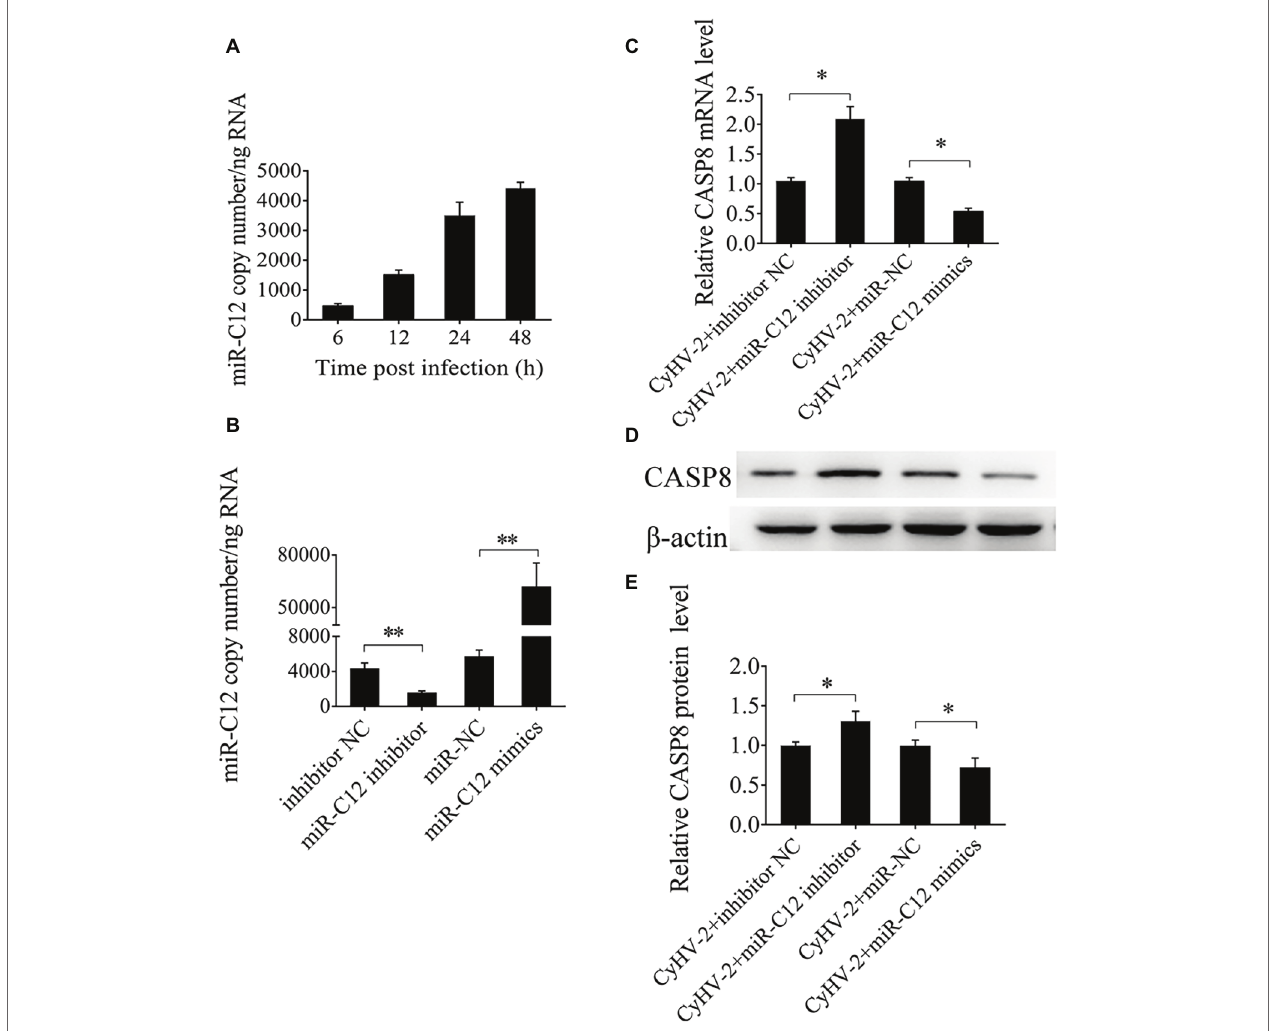
FIGURE 4 | Effect of miR-C12 on caspase 8 expression. (A) Expression of miR-C12 in CyHV-2-infected GiCF cells. miR-C12 expression levels at 6, 12, 24, and 48 h post infection was measured by qRT-PCR. (B) Effects of the miR-C12 inhibitor or miR-C12 mimics on miR-C12 expression. miR-C12 expression levels were quantified by qRT-PCR at 24 h post-transfection in CyHV-2-infected GiCF (MOI = 0.1) cells transfected with the miR-C12 inhibitor and the inhibitor negative control or miR-C12 mimics and miR-NC. (C) Effect of miR-C12 on caspase 8 mRNA expression in CyHV-2-infected GiCF cells. qRT-PCR detection of caspase 8 in CyHV- 2-infected GiCF cells treated with the miR-C12 mimic or miR-C12 inhibitor. (D,E) Effect of miR-C12 on caspase 8 protein expression. Western blot detection of caspase 8 in CyHV-2-infected GiCF cells. The miRNA negative control and inhibitor negative control were included in the experiments, β -actin was used as a control. ** p < 0.01; * p <